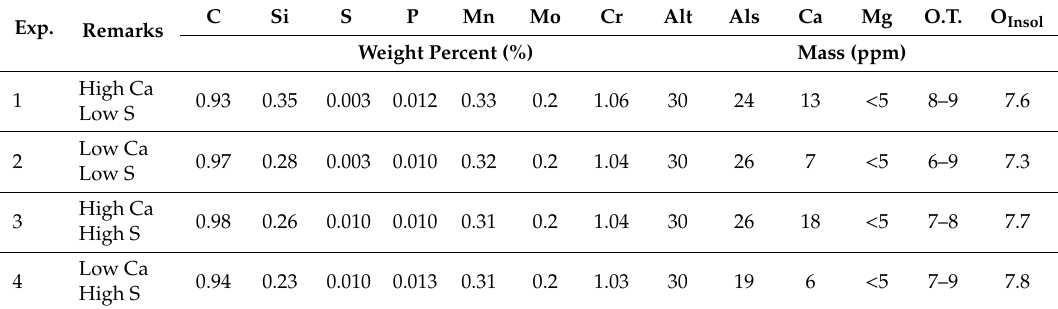
Table 1. Chemical compositions of steel billets for